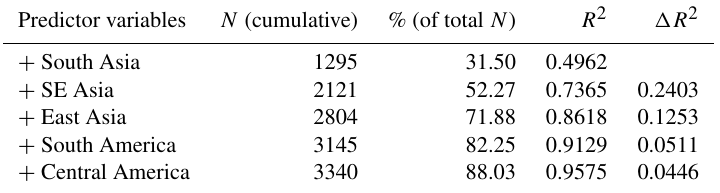
Table B1. Hierarchal linear regression results comparing the impact of seasonality in geographical regions with the global mean number of landslides per pentad through the annual cycle (see Fig. 4). The data series for each geographical region are sequentially added into the regression (such that the second row of the table is a regression of South Asia + SE Asia with the global